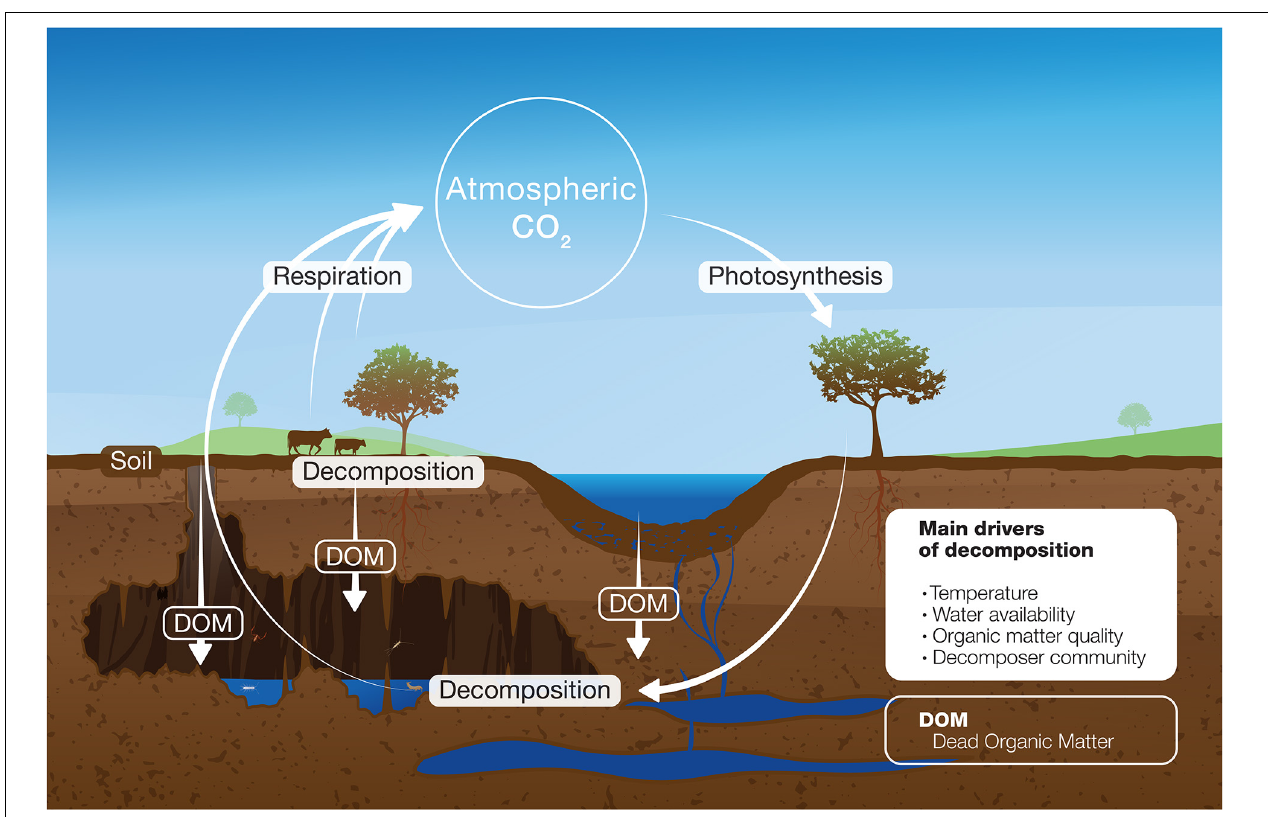
FIGURE 1 | Conceptual model of organic matter decomposition in